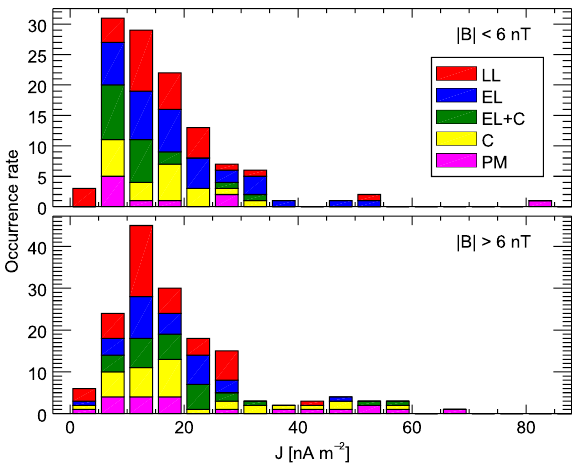
Figure 14. Occurrence rate of current density magnitudes averaged across each current event for solar wind magnetic field magnitudes smaller (upper panel) and greater (lower panel) than